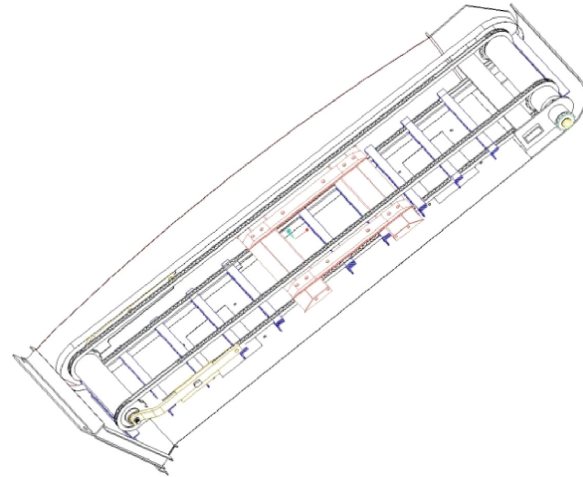
Figure 5: Assembly of the header platform. Figure 6: Assembly of conveying